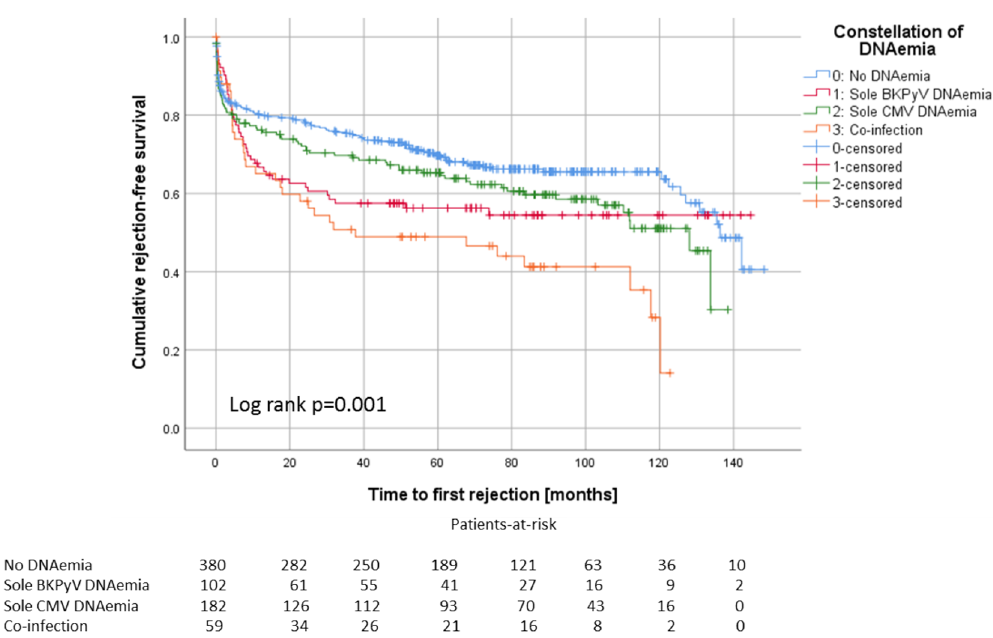
Figure 3. Kidney recipients who developed co-infection, showed the highest incidence of rejection episodes compared to those without viremia, BKPyV DNAemia or CMV DNAemia alone (Log-rank p =